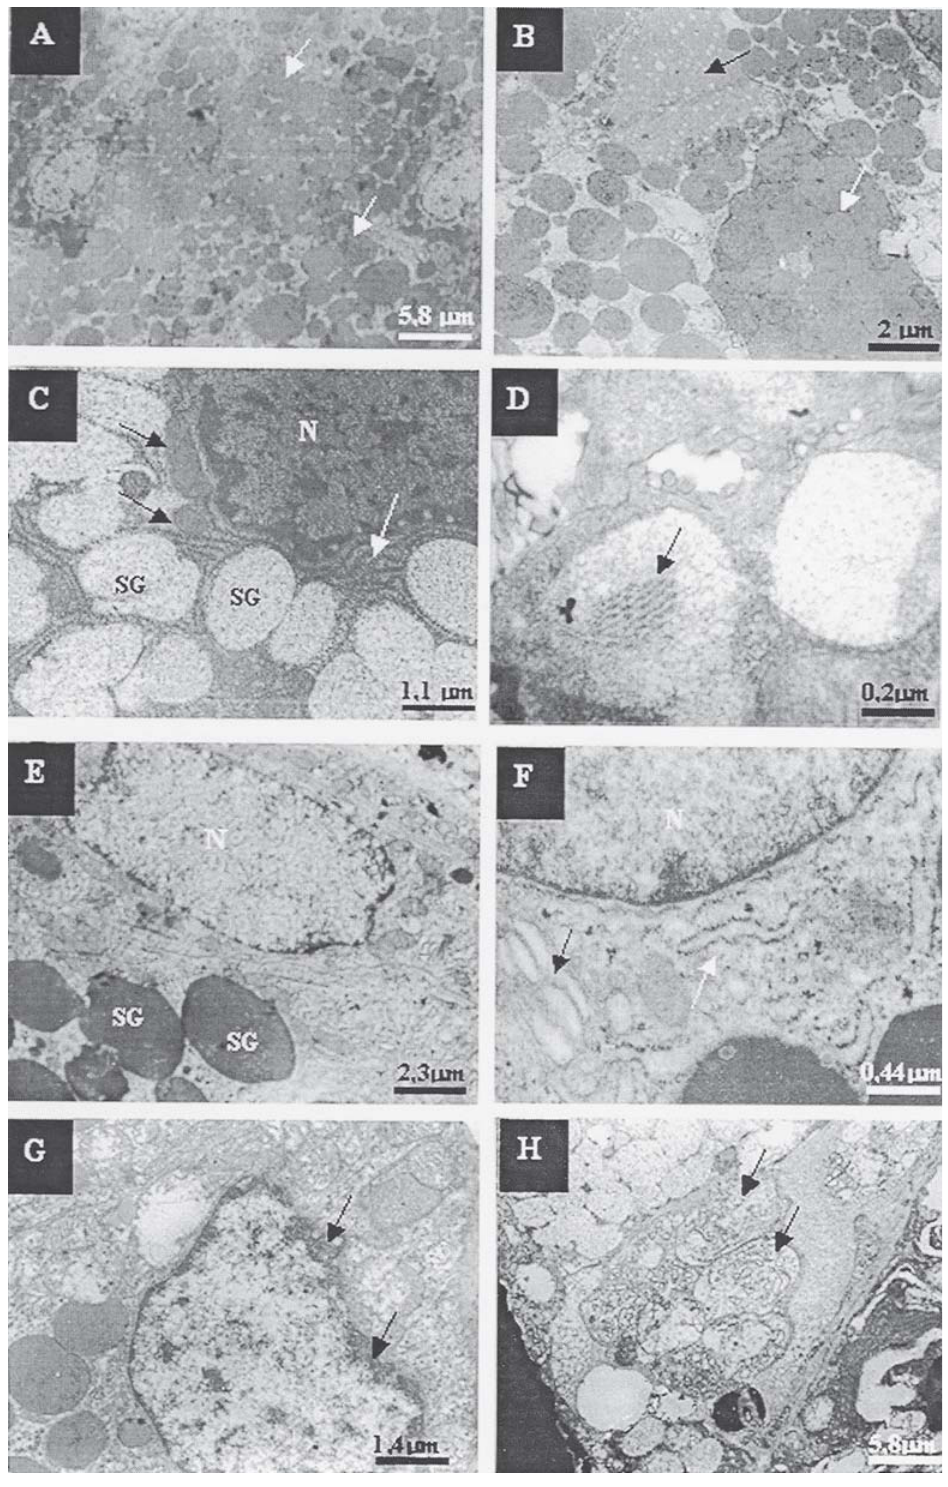
FIGURE 1- Transmission electron microscopy of the control group and irradiated submandibular salivary gland tissue 4 h after gamma ray irradiation. (A) Control group: convoluted granular tubules with serous cells presented secretion granules (white arrow). (B) Irradiated group: convoluted granular tubules with serous cells presented serous secretion granules with bonds (white arrow) and decreased electrodensity of contents (black arrow). (C) Control group: mucous cell presented mitochondria (black arrow), secretion granules (SG), nuclei (N) and rough endoplasmatic reticulum (white arrow). (D) Irradiated group: acini with mucous cells presented fibril-like condensations (arrow) in mucous granules. (E) Control group: serous cell presented nuclei (N) and secretion granules (SG). (F) Control group: serous cell presented nuclei (N), rough endoplasmatic reticulum (white arrow) and Golgi complex (black arrow). (G) Irradiated group: pleomorphic nucleus with thickened membrane (black arrow) and chromatin condensation, surrounded by degenerated organelle (white arrow) and free polyribosomes. (H) Irradiated group: vacuoles with varying content of nucleus and cytoplasm (arrow).